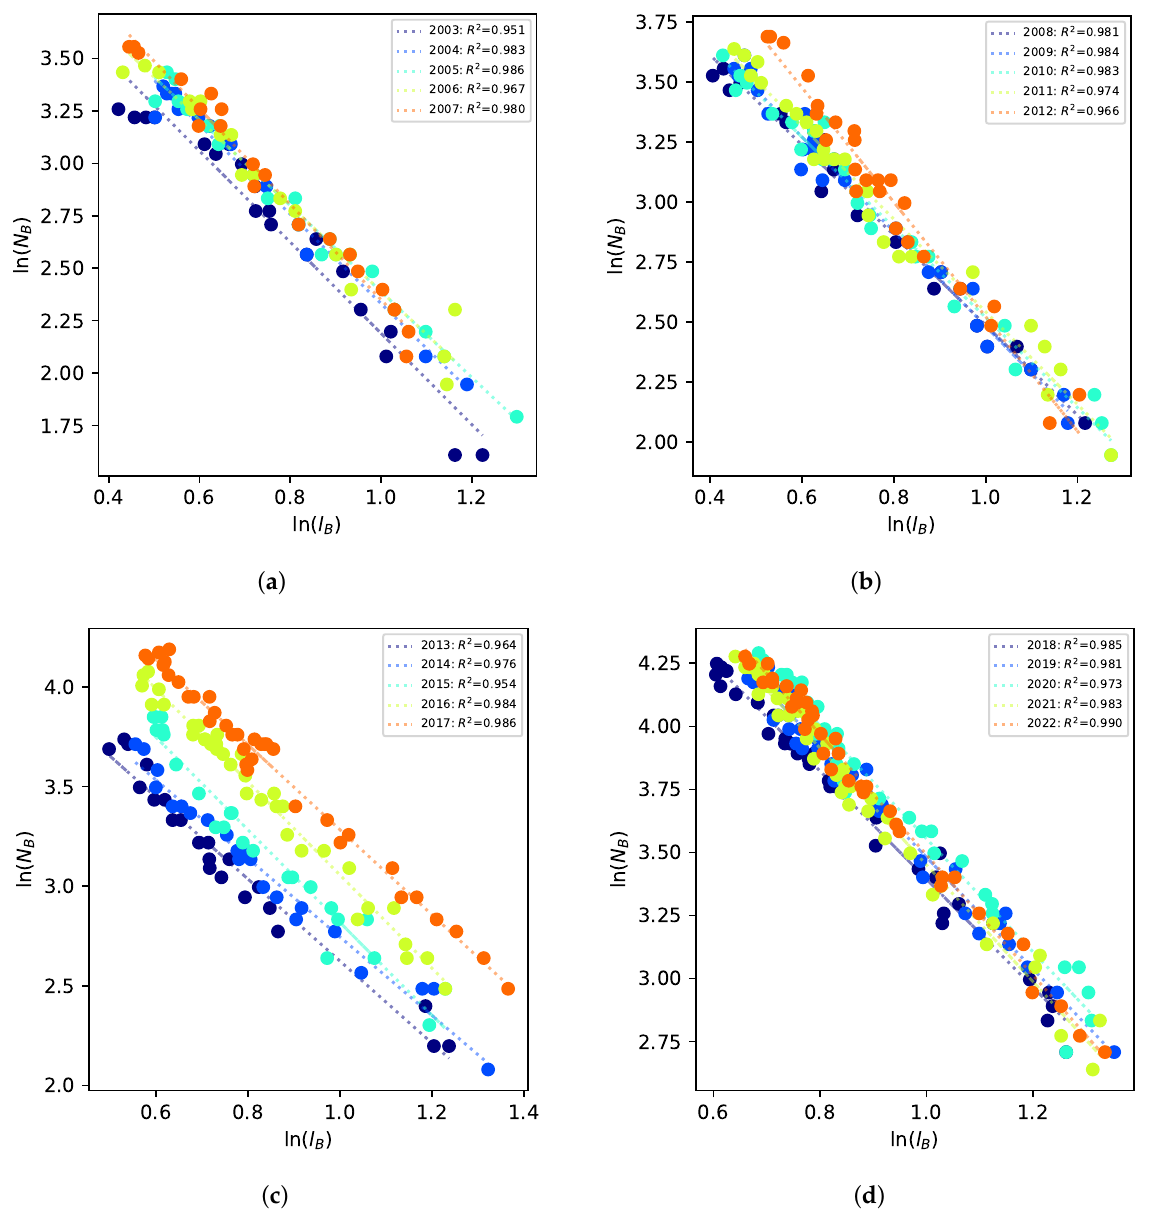
Figure 8. Power-law relationships between the number of boxes N B and the average size l B . Clear- cut linear relationships can be observed between ln ( N B ) and ln ( l B ) , which reveal the fractality of the snapshots. ( a ) Snapshots of 2003–2007. ( b ) Snapshots of 2008–2012. ( c ) Snapshots of 2013–2017. ( d ) Snapshots of